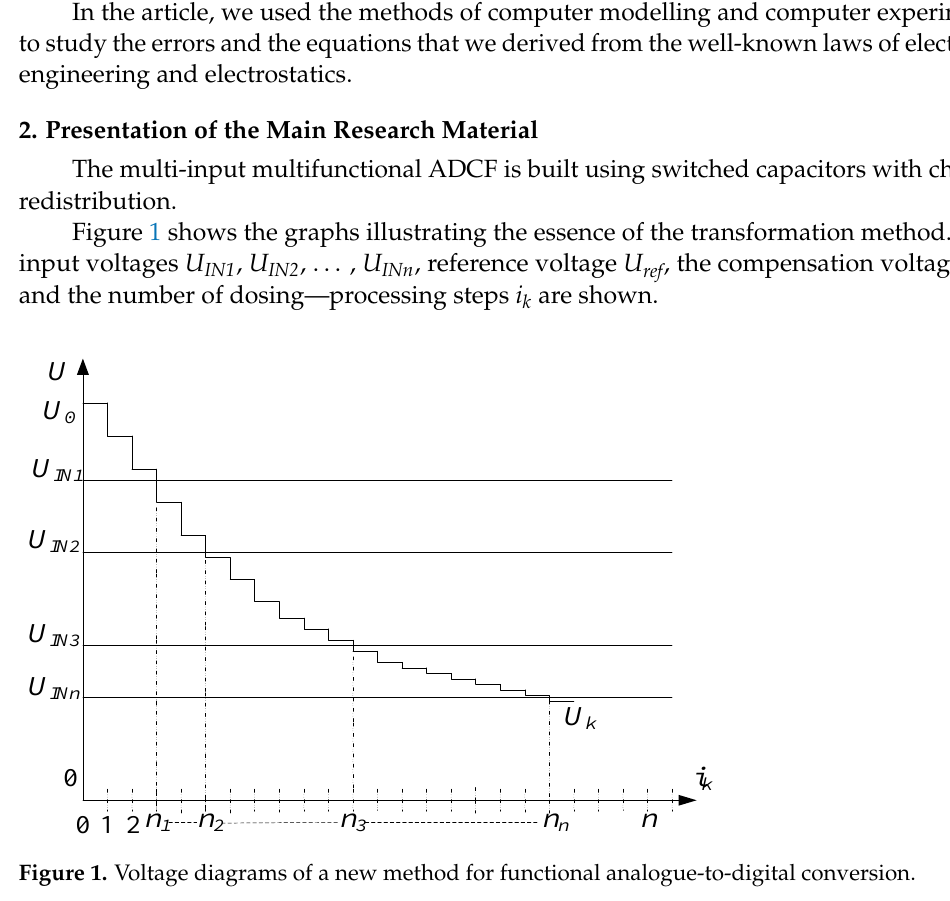
5 of 13 Figure 2 includes: U k — compensation voltage, U IN min — the smallest of the input volt- ages, U ref — reference voltage, i k — number of dosing — processing steps, n i — number of log-